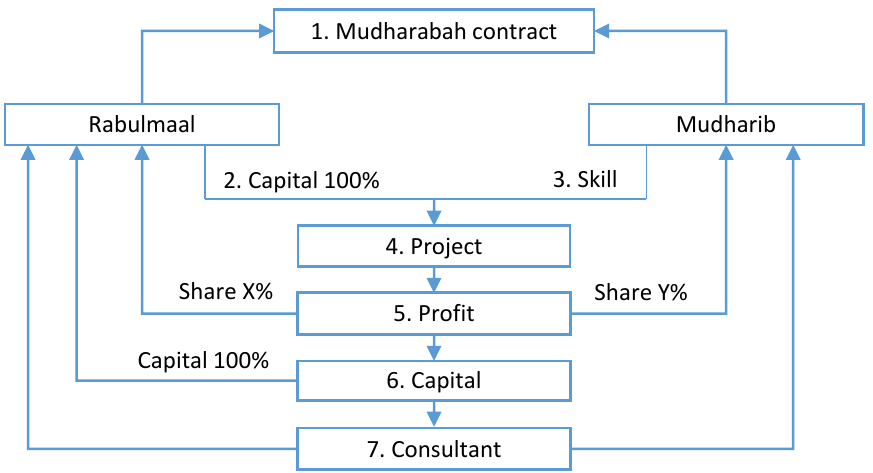
Figure 2. Proposed Mudaraba financing